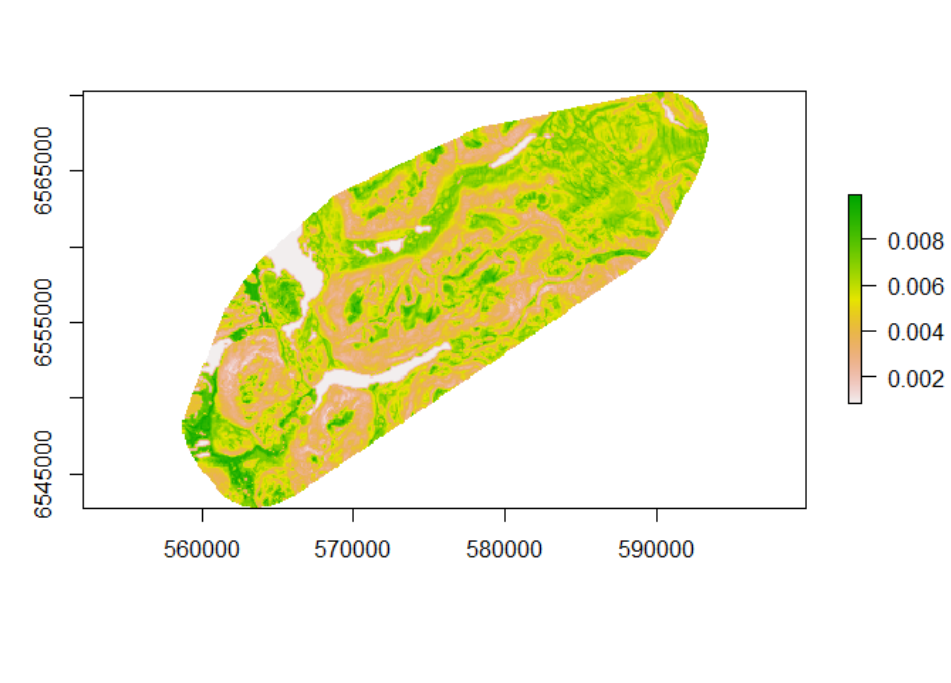
Figure 13: Output of conductance